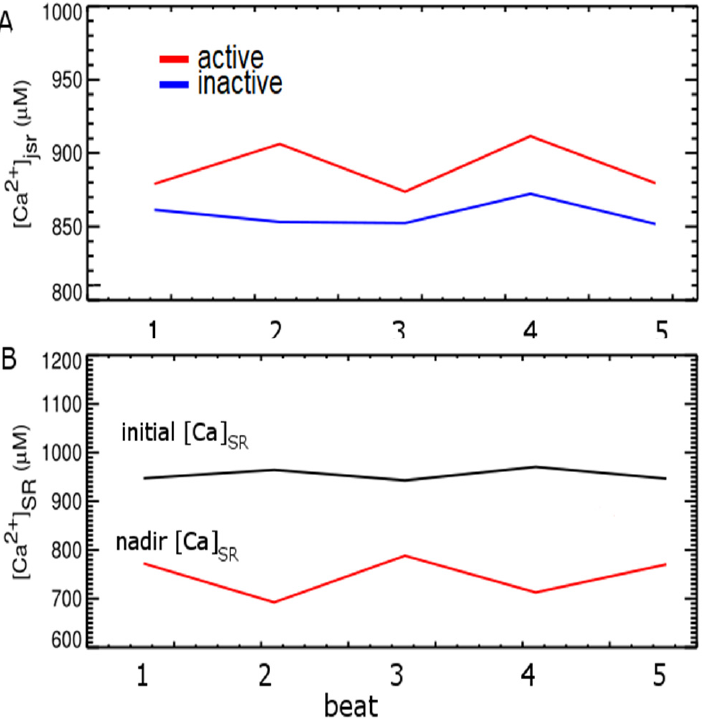
shown in our previous study, the activation of a CRU is the result of 8-10 RyR2 opening